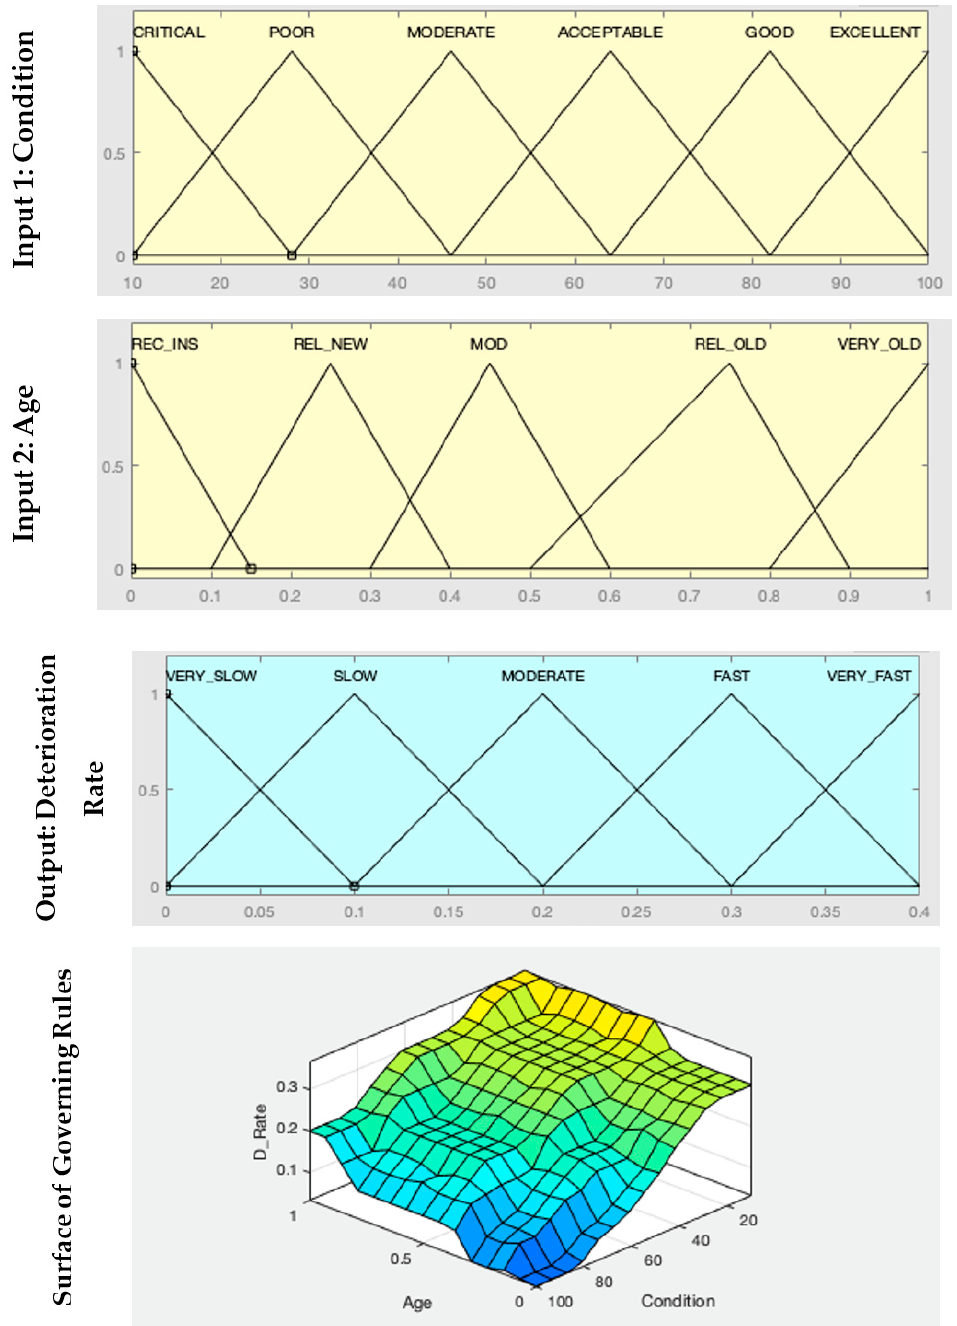
Figure 1. Parameters and rules of the fuzzy deterioration framework.